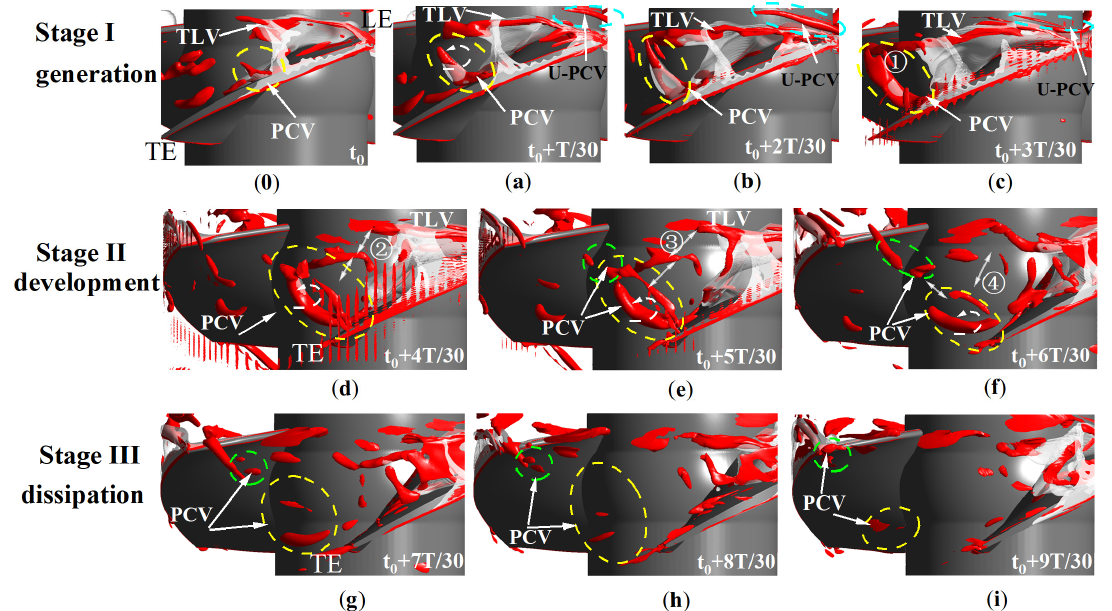
Figure 8. Transient evolution of PCV and cavitation obtained via simulation (swirling strength isosurface Sw = 1000 s − 1 (red), and the cavitation volume fraction isosurface α v = 0.1 (white), Q = 0.8 Q BEP , σ = 0.35 ) .